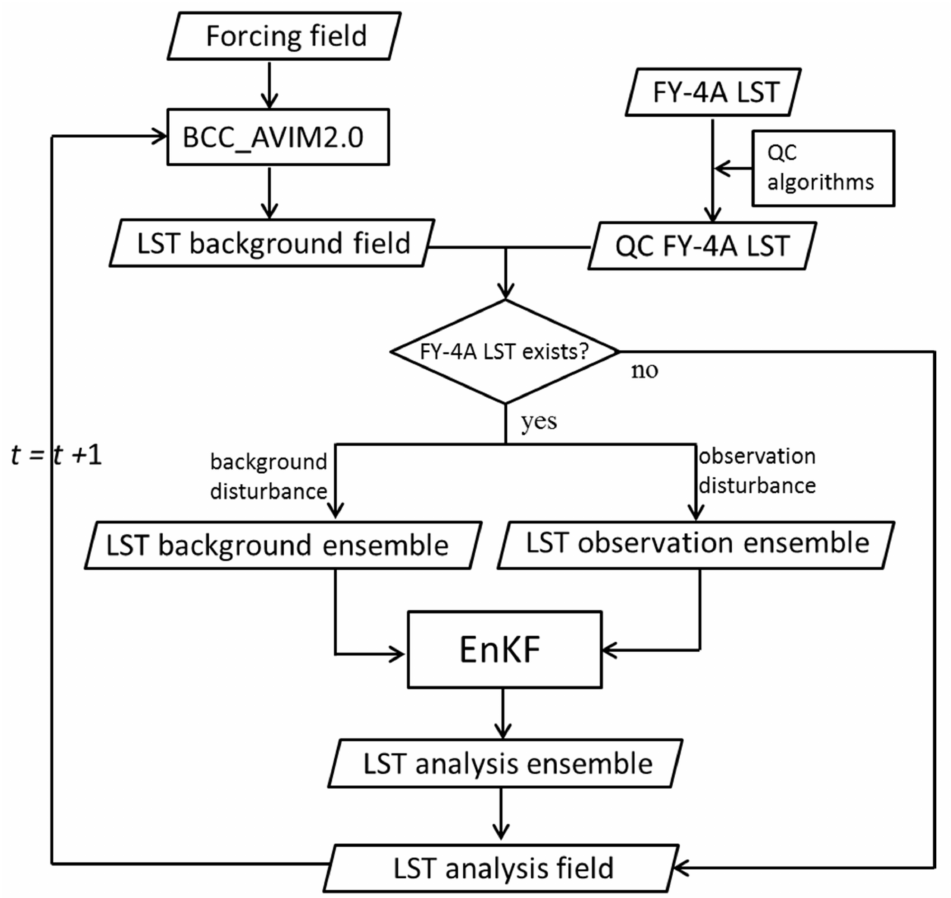
Figure 1. Flow chart of the FY-4A LST assimilation